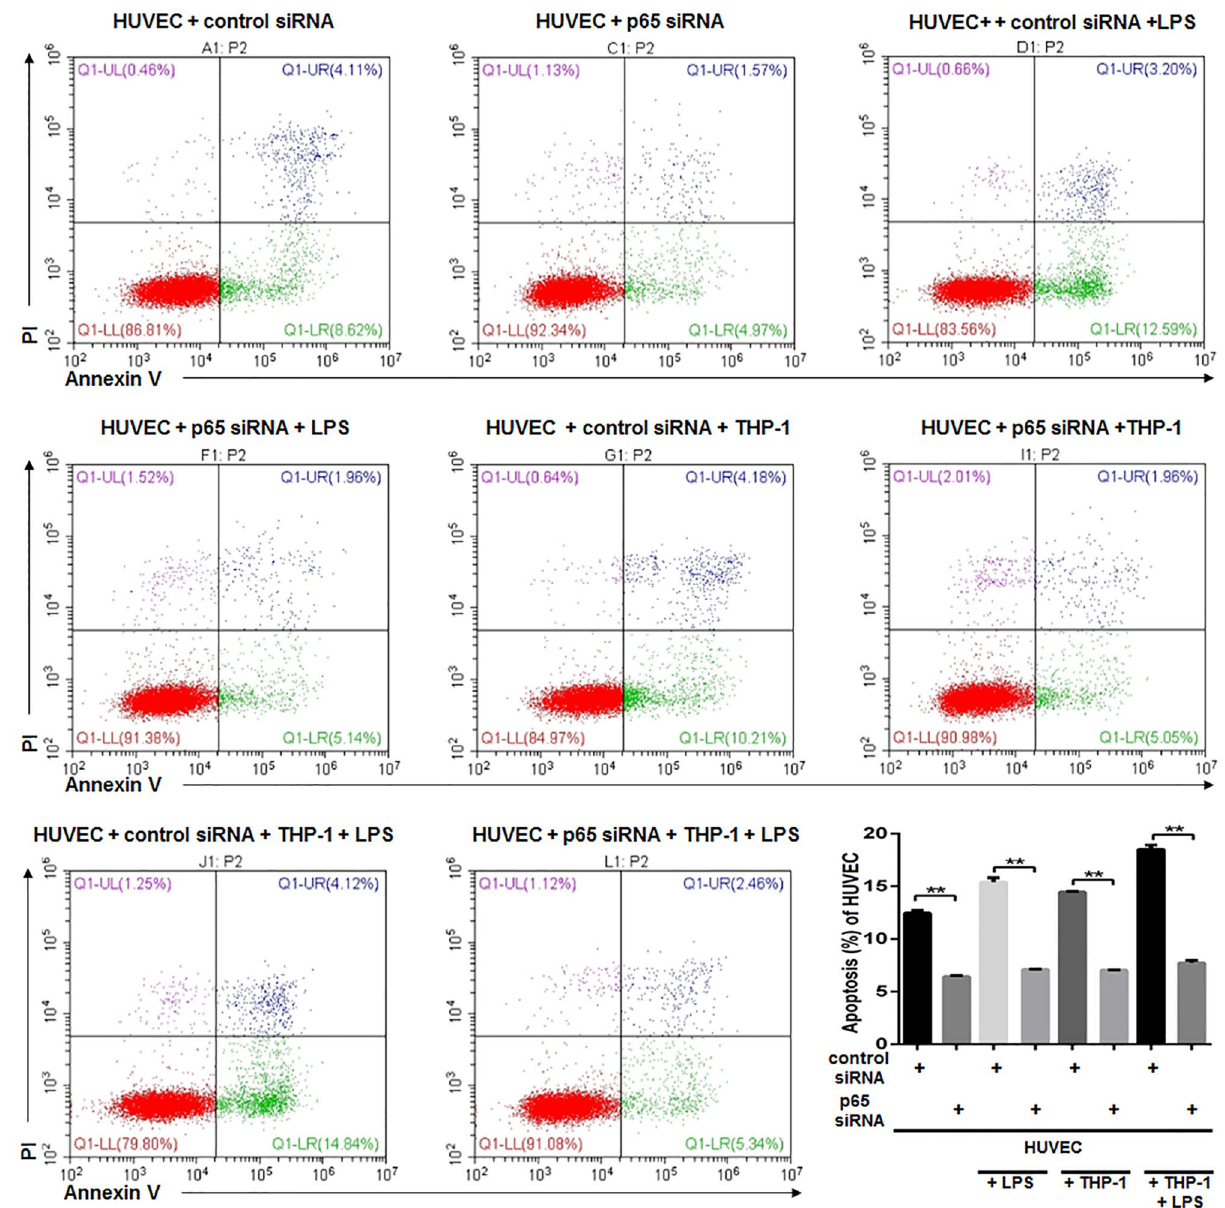
Figure 7. SiRNA-mediated silence of p65 significantly attenuated apoptosis of HUVECs under various conditions. HUVECs were transfected with p65-targeting plasmid or control siRNA for 24 h; and then the HUVECs were cultured alone with/without LPS (100 μg/mL) for 8 h, or co-cultured with THP-1-derived macrophages with/without LPS (100 μg/mL) for 8 h. Apoptosis of HUVECs was quantitated by Annexin V and PI staining via flow cytometry. Annexin V + cells are considered as apoptotic cells. n = 3 for each group. Data are expressed as mean ±